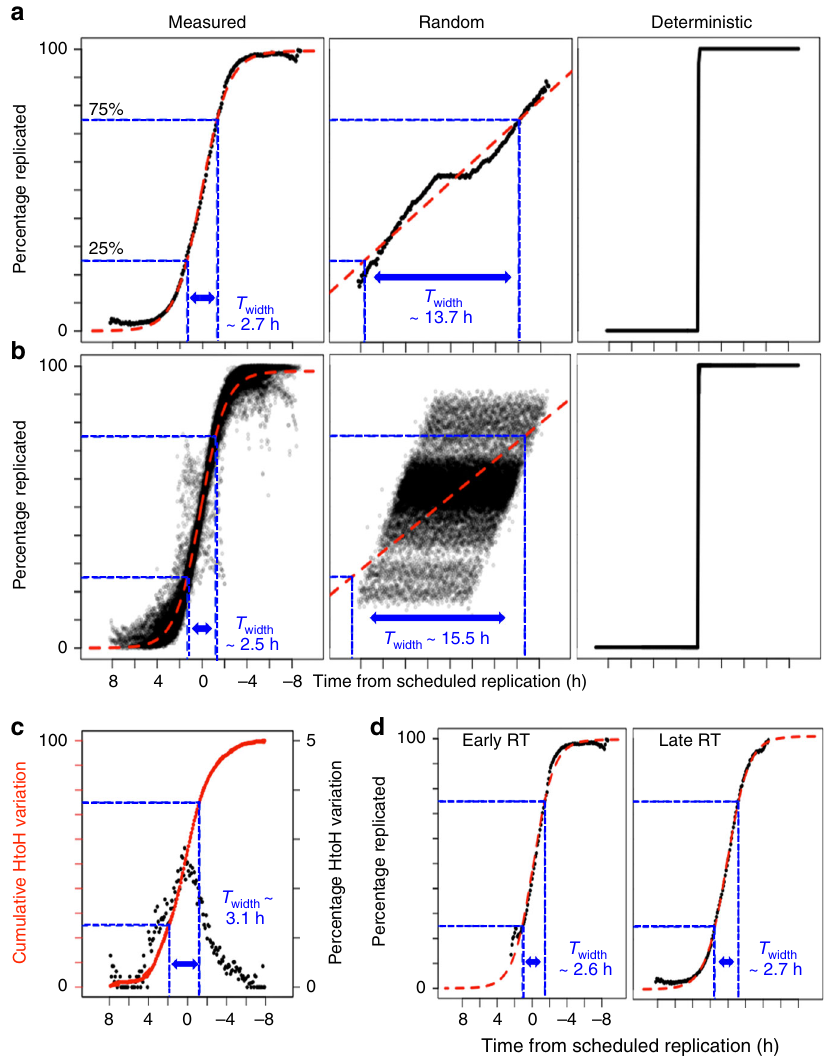
Fig. 3 Measuring single-cell replication variability. a Cell-to-cell variability vs. “ time from scheduled replication ” in hours. The mean across all 50 kb bin positions is plotted for each 0.1 h interval on the x axis and the red line is the sigmoid fi t. Control models of random vs. deterministic replication are shown for comparison. b Within cell variability across the genome plotted for each single-cell independently, similar to a . c Homolog-to-homolog variability vs. “ time from scheduled replication ” . The black scatter plot measures percentage of bins that show homolog asynchrony (right y axis) for each 0.1 h interval on x axis. The overlapping solid and dotted red line are the cumulative sum of the variability and it ’ s sigmoid fi t, respectively (left y axis). d Cell-to-cell variability for early (RT > 0) vs. late replicating regions (RT < punctuated by segments of DNA that replicate gradually later with time, termed timing transition regions (TTRs) 2 . The binar- ized single-cell data from mid-S cells reveals conserved locations of copy number shifts that align with TTRs observed in the population-based data (Fig. 4a). The aggregate alignment of TTR centers (mid-transition) to the closest single-cell copy number shifts reveals a strong enrichment of the copy number shifts near the population-based TTR centers (Fig. 4b). In principle, the positions of copy number shifts should show maximum distinc- tion between early and late replicating CTRs in cells that were in mid-S phase. Consistent with this, the alignment of single-cell copy number shifts to TTRs is highest in cells ranked closer to the middle of S-phase (Fig. 4b). The randomized control does not show any enrichment whereas the deterministic simulation shows near perfect enrichment at TTRs in mid-S phase cells. Thus, the regions of timing transition from early replication to late repli- cation are conserved in single cells.